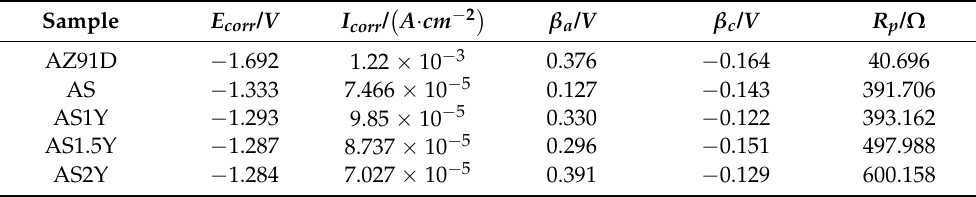
Figure 9. Potentiodynamic polarization curve. Table 4. Electrochemical parameters calculated from the results in Figure